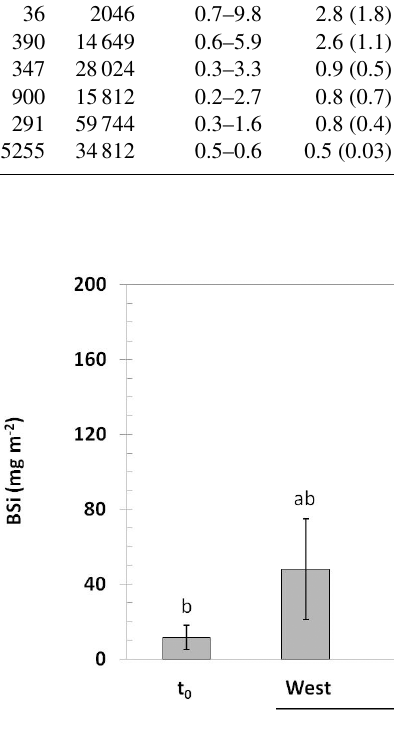
Figure 3. Total biogenic Si pools in soils (means ± standard devia- tion, upper 5cm) at Chicken Creek at the end of construction work ( t 0 ) and after 10 years of ecosystem development (western, east- ern and southern sections, t 10 ). Significant differences are indicated by different letters ( p <0.05, Kruskal–Wallis ANOVA with Dunn’s post hoc